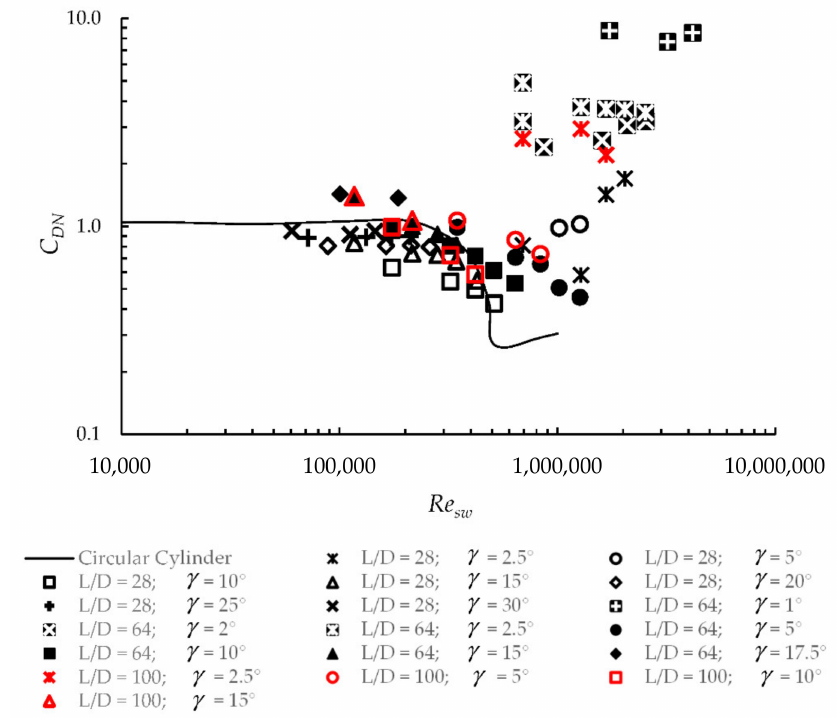
Figure 6. Plot of C DN vs. Re sw for the three different aspect ratio cylinders and range of yaw angles. The solid line represents the drag coefficient for a circular cylinder that was aligned perpendicular to the